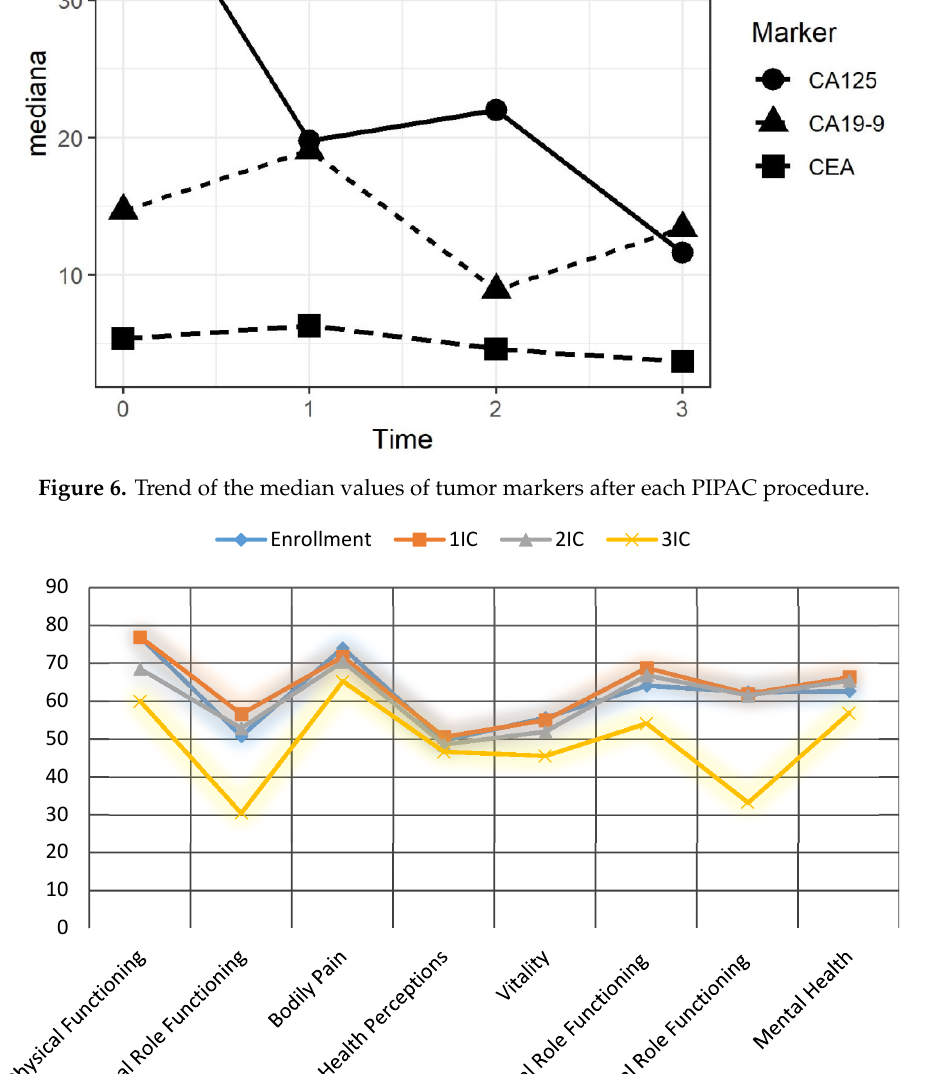
Figure 7. Influence of PIPAC on QoL assessed with SF-36 questionnaire.